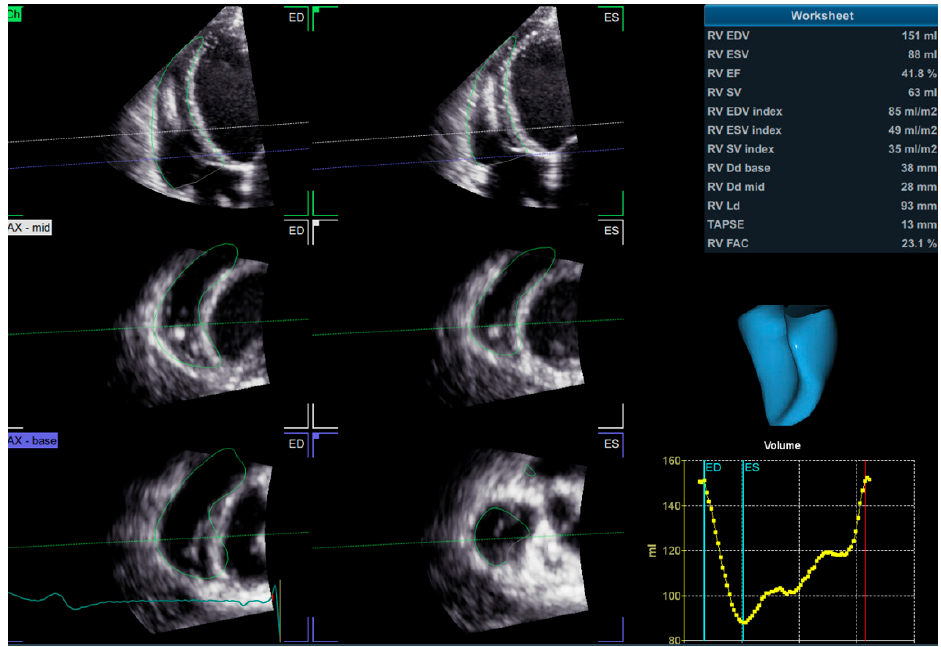
Figure 4. 3D assessment of RV volumes and ejection fraction using dedicated software. 3D—three dimensional; RV—right ventricle.